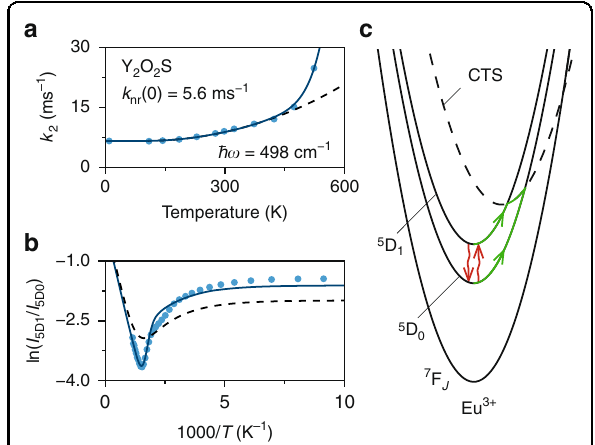
Fig. 5 The impact of charge-transfer quenching on the onset of thermal equilibrium. a Decay rates of the 5 D 1 emission at various temperatures. The dashed black line is a fi t of the experimental rates (blue dots) up to 423 K to Eq. 1, while the solid blue line is a fi t to Eq. 7. b Intensity ratios between the 5 D 1 and 5 D 0 emissions for various temperatures extracted from luminescence spectra. The dashed black line is a fi t of the experimental ratios (blue dots) to Eq. 4, while the solid blue line is a fi t of Eq. 8. c Con fi gurational coordinate diagram of the 5 D 0 – 1 and 7 F J levels of Eu 3 + including the charge-transfer state (CTS) of Y 2 O 2 S. Coupling between the 5 D 1 and 5 D 0 levels takes place directly via phonon emission and absorption (red arrows) and indirectly via crossover to the CTS (green